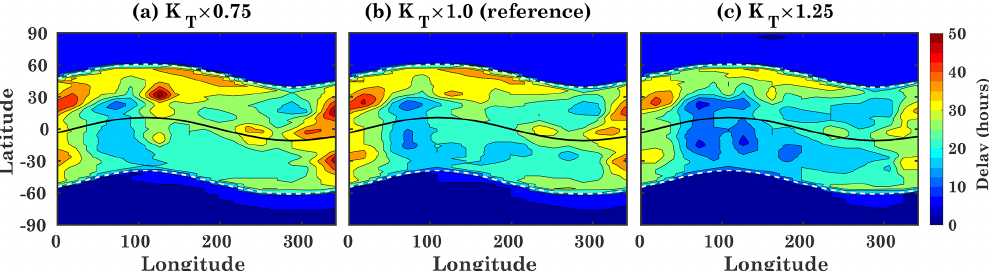
Figure 6. Spatial distribution of time delay between the CTIPe-TEC and the F10.7 index for different transport conditions, (a) K T × 0 . 75, (b) K T × 1 . 0 (reference), and (c) K T × 1 . 25. The black line represents the magnetic equator, and dashed white lines represent magnetic latitudes (55 ◦ N/S).